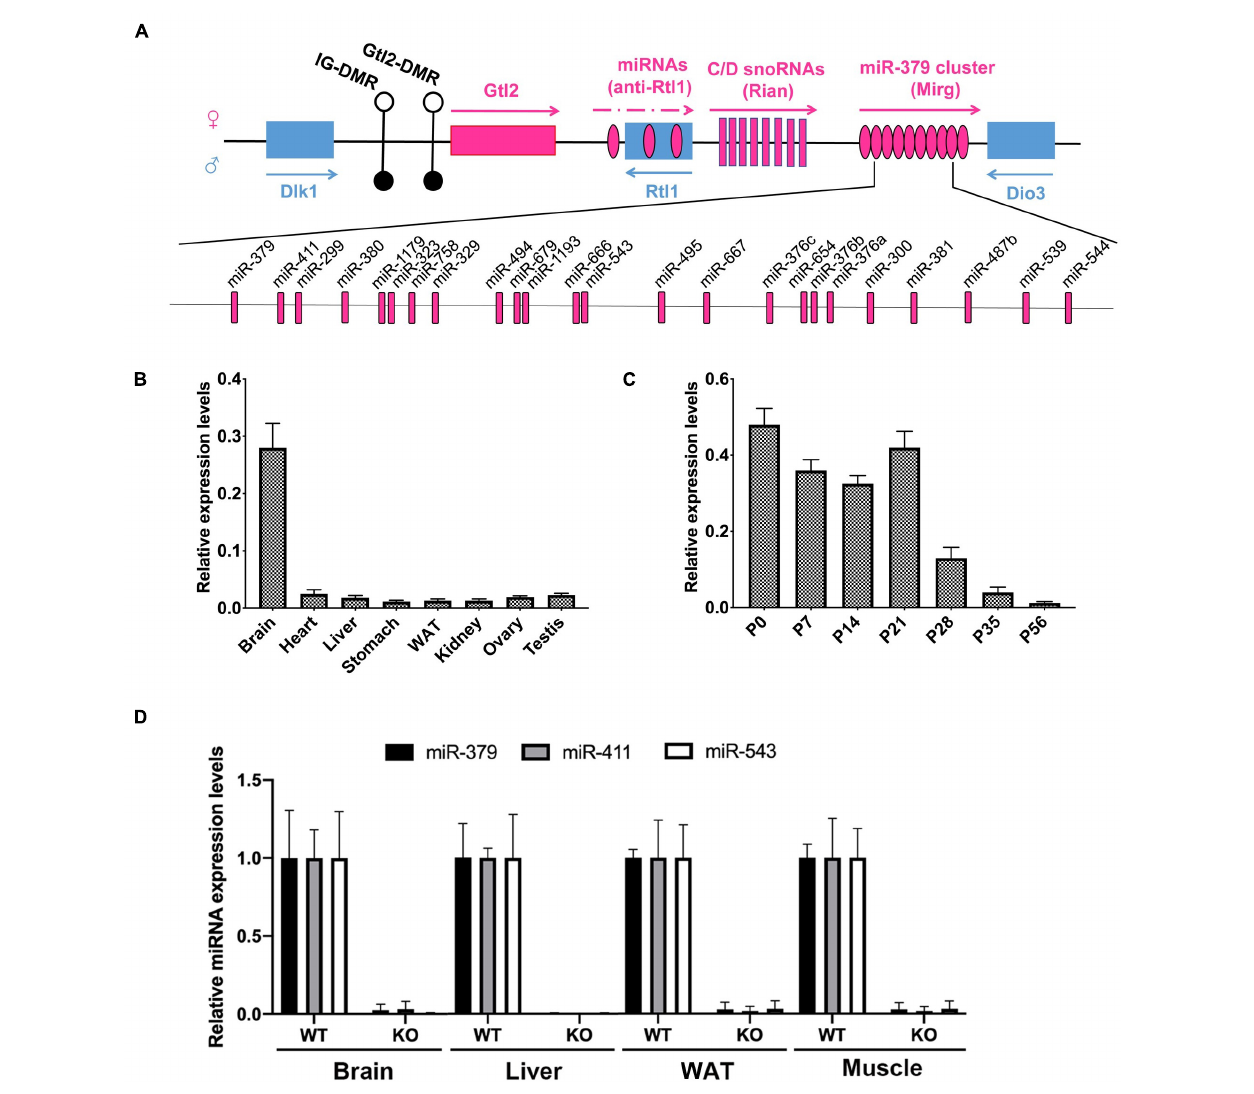
FIGURE 2 | Expression of the miR-379/miR-544 cluster in multiple tissues and developing livers in mice. (A) Schematic representation of miR-379/miR-544 cluster at the imprinted Dlk1-Dio3 region on the mouse distal chromosome 12 (human 14q32). (B) Expression pattern of the pri-miR-379/miR-544 cluster transcript in eight different adult mouse tissues ( n = 4), assayed via quantitative PCR. (C) Expression pattern of the pri-miR-379/miR-544 cluster transcript in developing mouse livers ( n = 4). Livers at postnatal day 0 (P0, newborn), P7, P14, P21, P28, P35, and P56 were analyzed. (D) Expression of selected miRNAs scattered with miRNA cluster ( miR-379, miR-411, and miR-543 ) in brain, liver, WAT (white adipose tissue), and muscle from WT and the miR-379/miR-544 cluster KO mice ( n = 3) at P20 was determined by quantitative